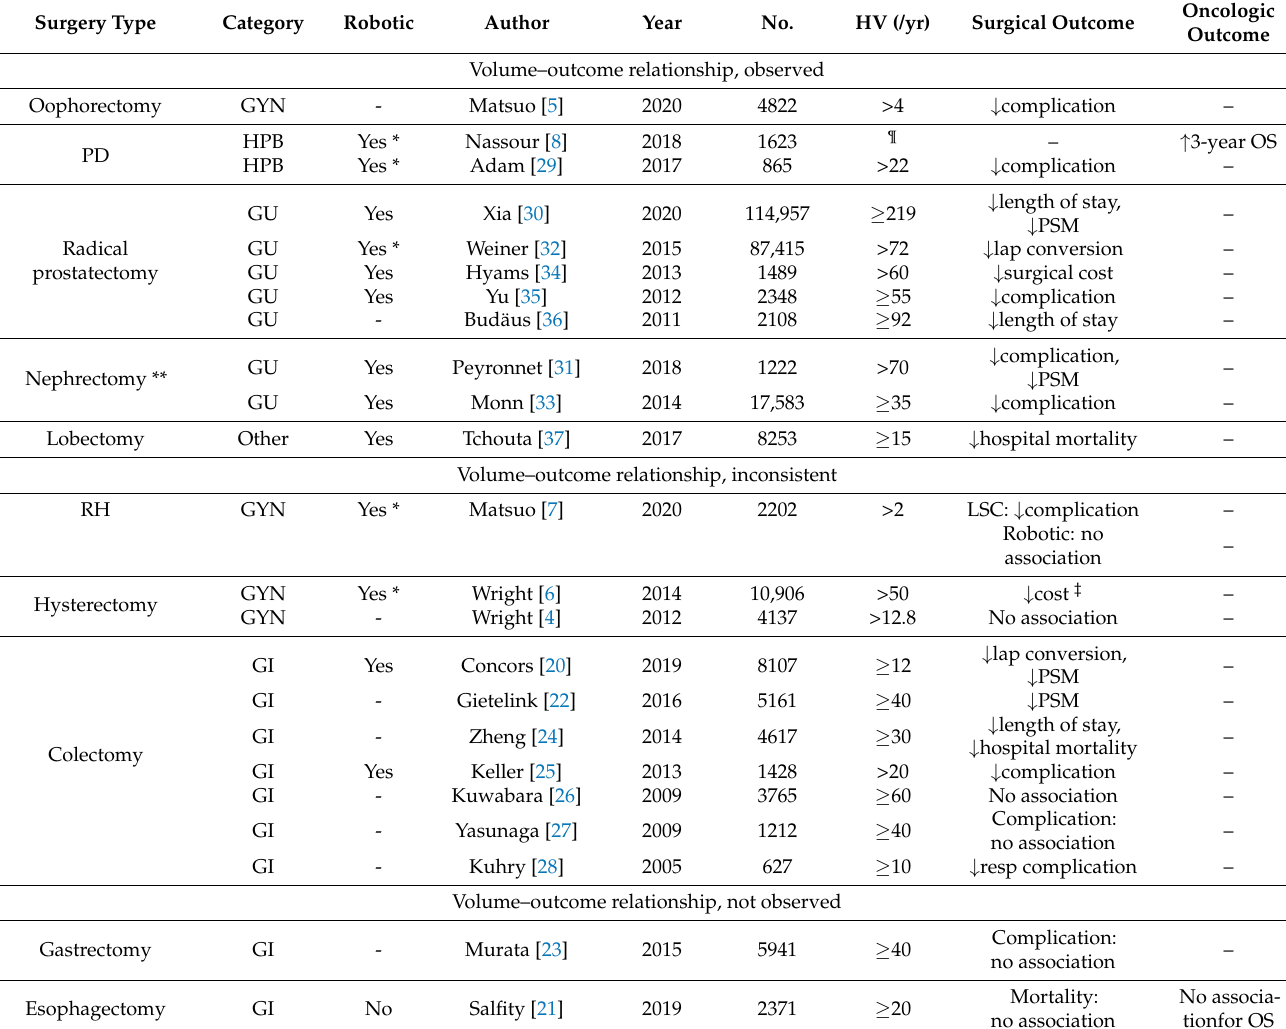
Table 2. Volume–outcome relationship in minimally invasive surgeries for malignant